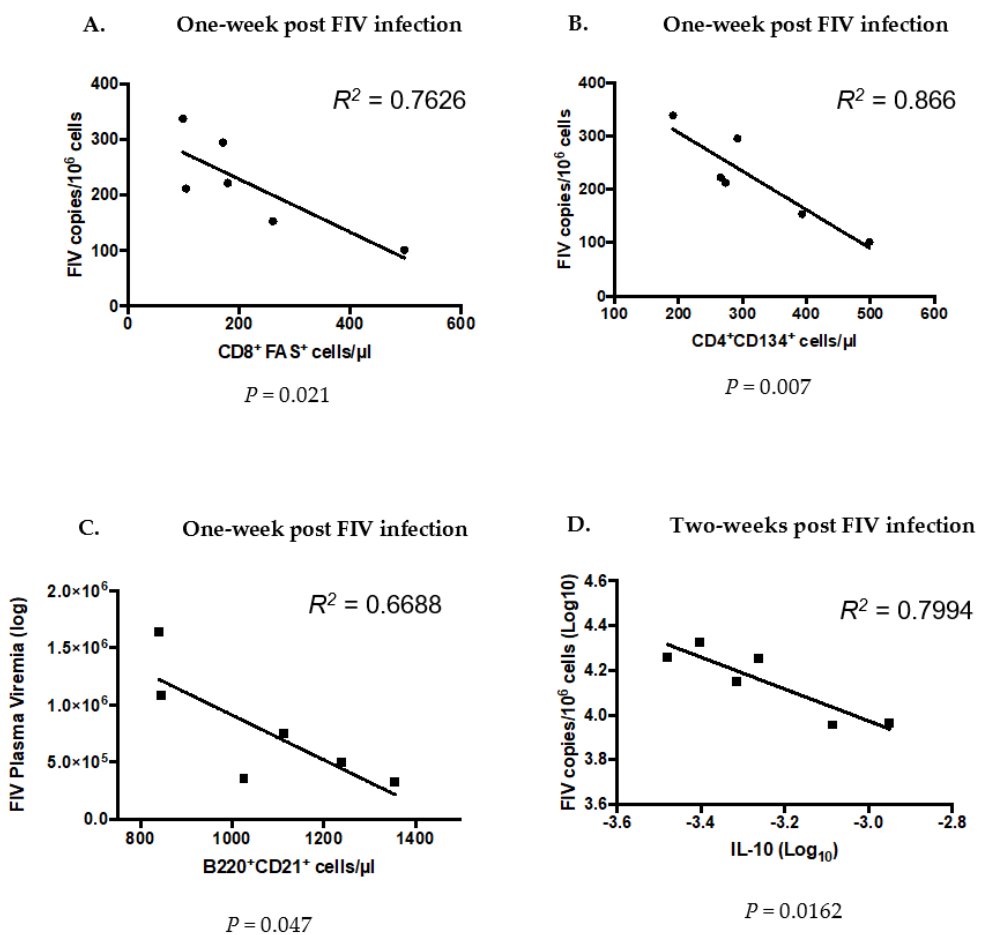
Figure 9. Linear regression analysis to determine cell phenotypes and cytokine expression that was different between the PLV (CO) and SHAM cats at week zero or time of FIV inoculation could predict future outcomes of FIV infection in CO cats. Higher CD8 + FAS + ( A ) and CD4 + CD134 + ( B ) cell numbers in the blood of CO cats (those previously infected with PLV) at week 0 could predict lower FIV proviral loads in blood at one week FIV ‐ PI, and that higher B220 + CD21 + ( C ) cell numbers in blood at week zero could predict lower FIV plasma viremia at one week FIV PI. Higher IL ‐ 10 mRNA expression in PLV ‐ cats at week 0 predicted lower FIV proviral loads at two weeks FIV PI ( D ).